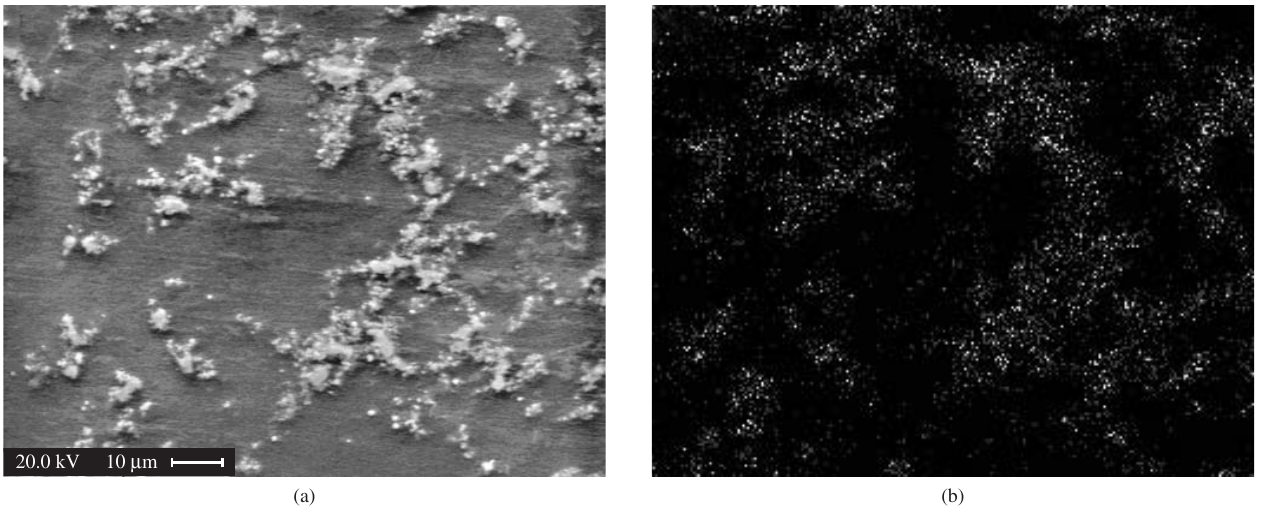
Figure 3. SEM analysis of magnesium matrix composites a) pattern; and b) Tik